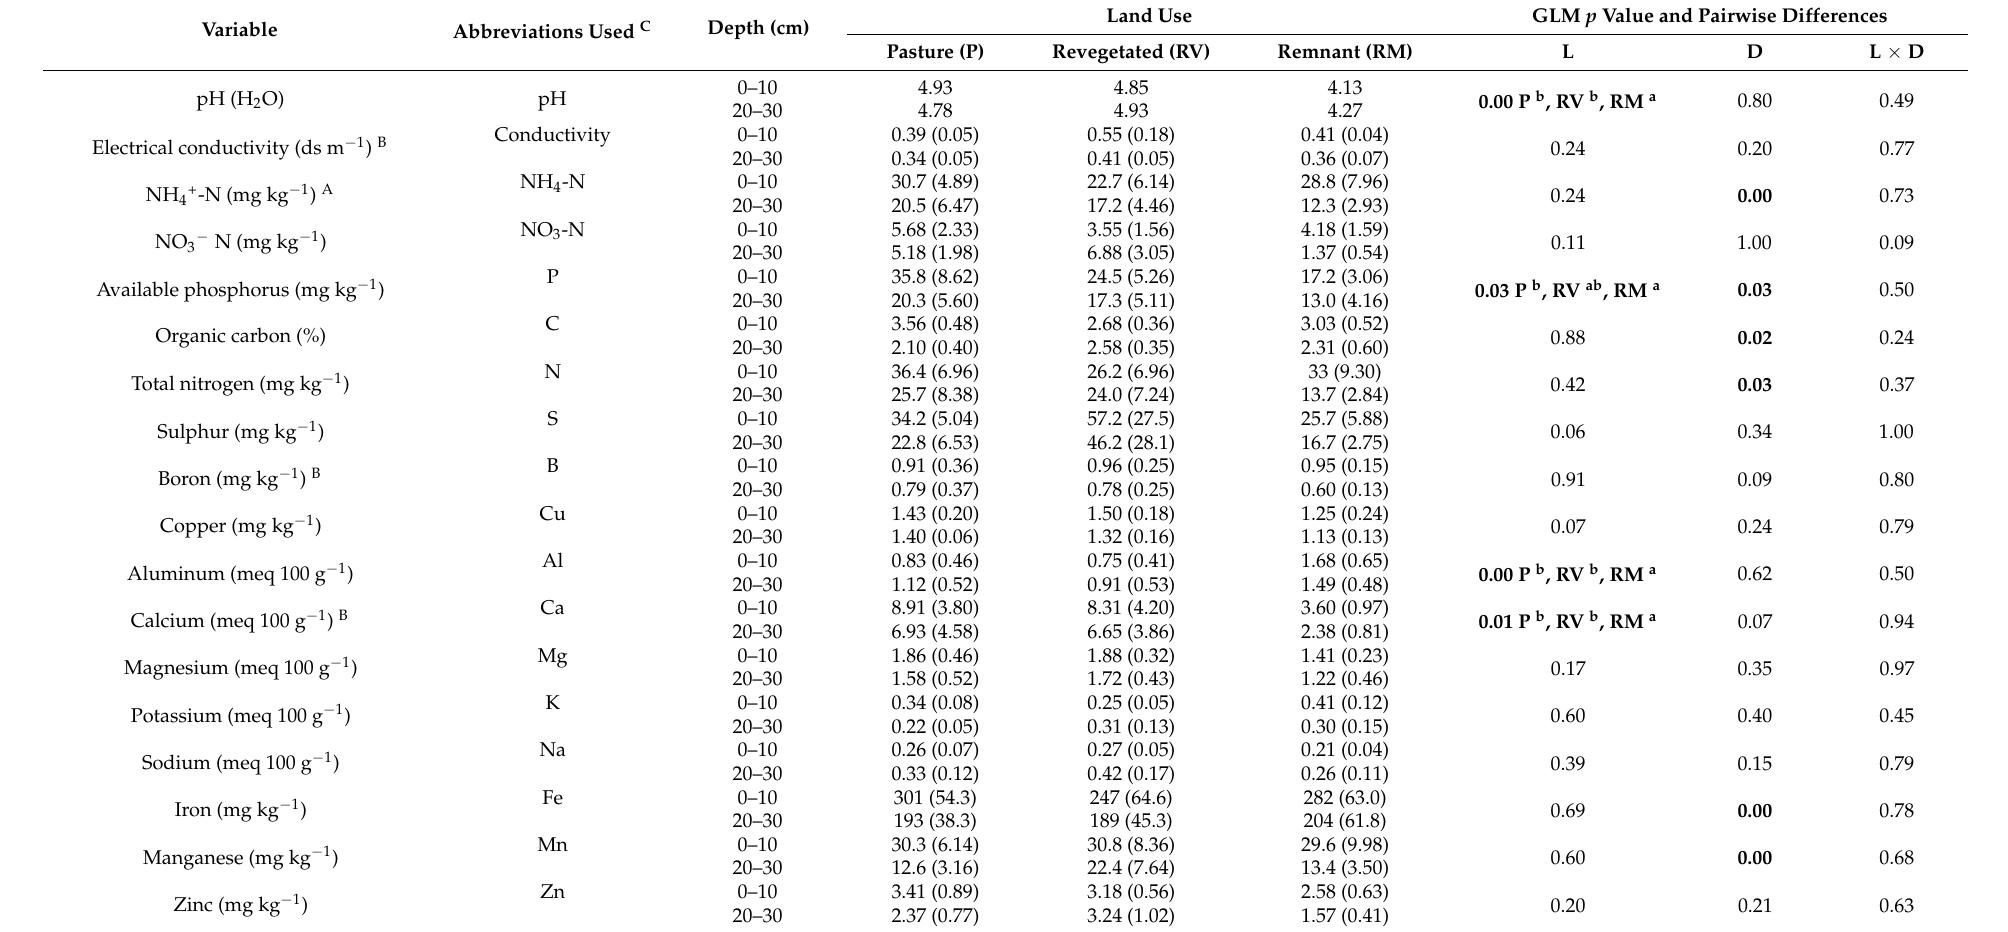
Table 3. Soil physicochemical properties of the three land-use types (P, pasture; RV, revegetated; RM, remnant) across six sites. Values represent means ( ± SE) with p values from general linear models (GLM) testing for the effects of land use (L) and depth